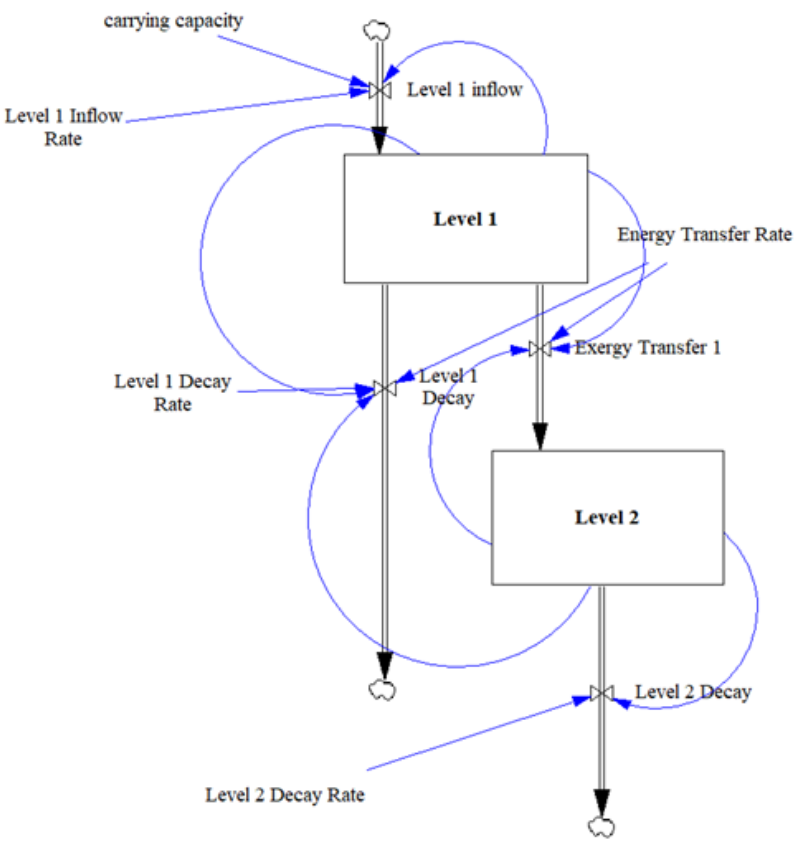
Figure 1. An interpretation of the 2-stock trophic chain model according to the conventions of system